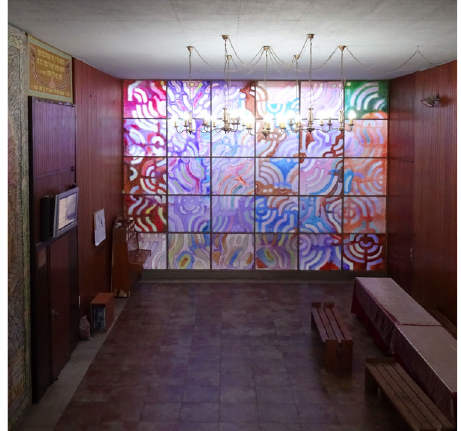
Fig. 9 Ruth Zarfati, Stained glass window at the synagogue ’ s lower vestibule (Photo by the